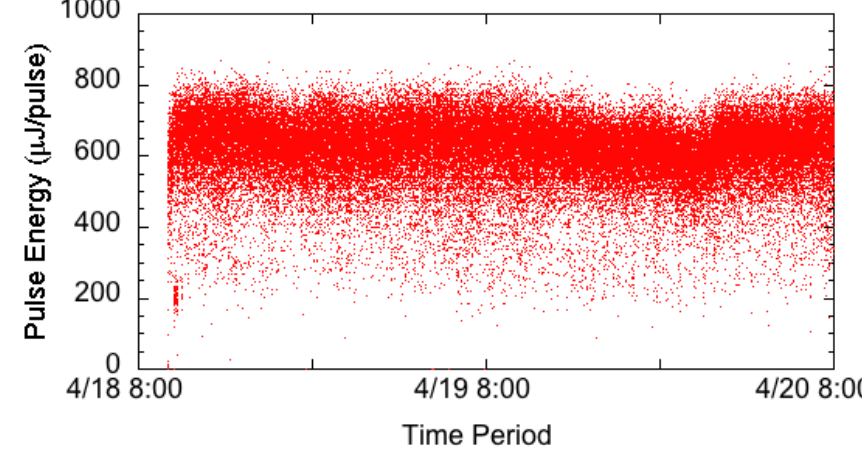
Figure 1. Trend of XFEL (X-ray Free Electron Laser) pulse energy at BL3 over 48 h on 18–20 April 2016. The average and peak pulse energies were 0.61 mJ and 0.87 mJ, respectively, at a photon energy of 10 keV. The rms pulse-energy fluctuation was 16%.